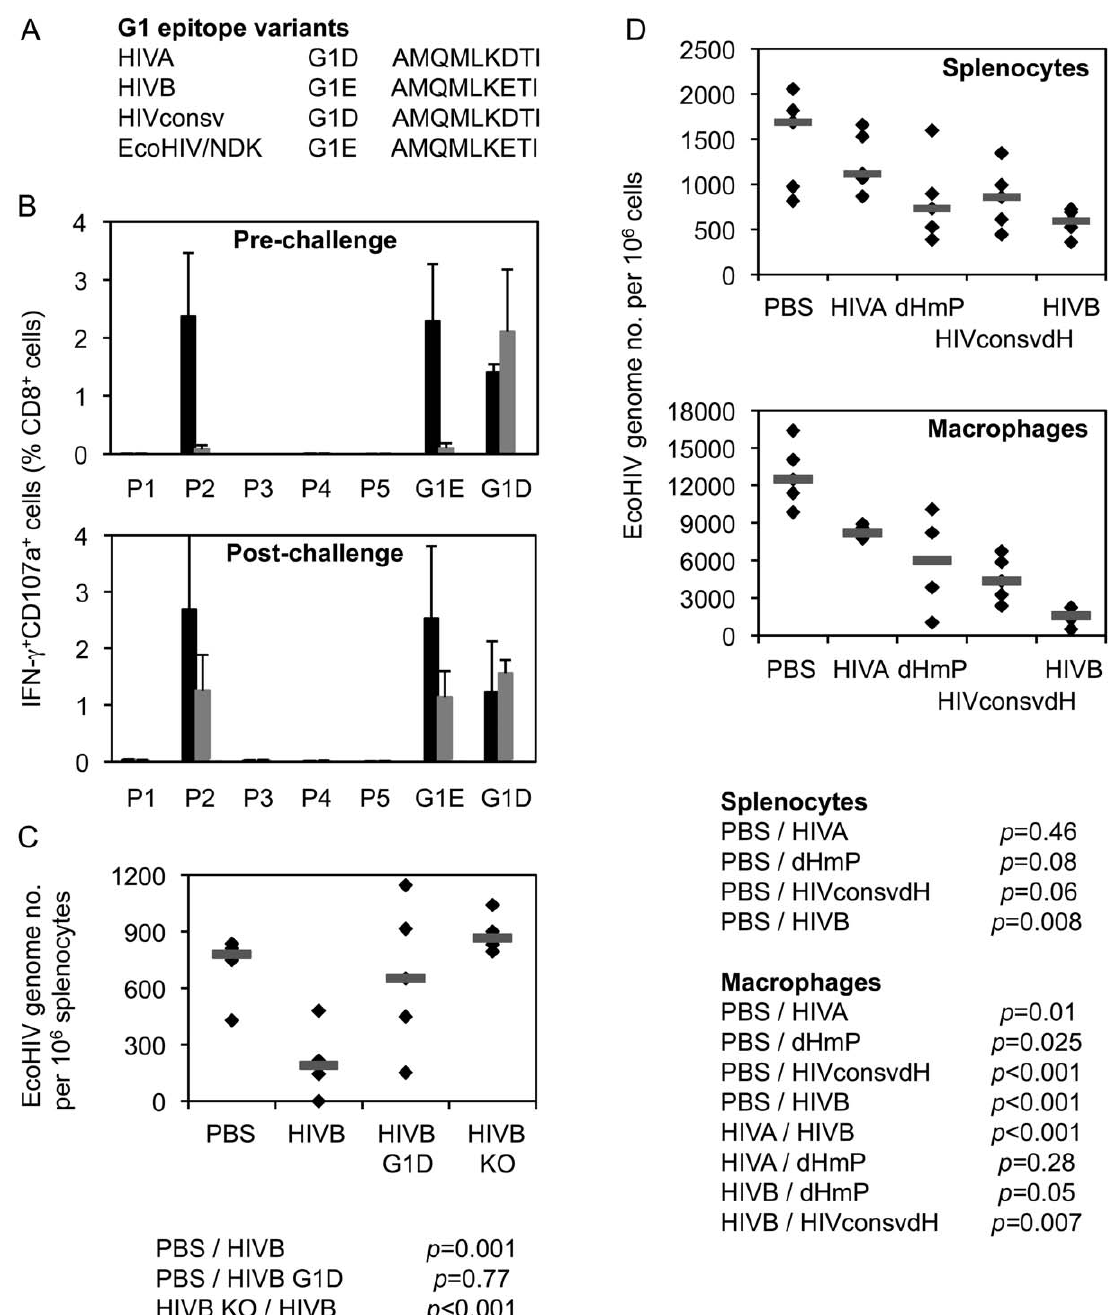
Figure 7. G1 epitope-specific CD8 + T cell responses confer protection against EcoHIV/NDK challenge. A) G1 epitope variants in the three used immunogens and the challenge EcoHIV. B) Eight BALB/c mice received 2x 100 m g of DNA of the HIVB vaccine containing epitope G1E (black bars), its G1D variant (dark grey bars) or knock-out versions (KO; light grey bars) and their HIVB-induced responses were determined before (n=3) or after (n=5) challenge with EcoHIV/NDK delivered 5 d after the last vaccination. For ICS assay, 5 pools (P1–P5) of overlapping peptides 15/11 across the whole HIVB protein and peptides G1E or G1D were used for re-stimulation as indicated below the graphs. Results are shown as mean 6 SD. C) The 3 vaccinated and 1 unvaccinated control groups of 5 mice were challenged with EcoHIV/NDK and the EcoHIV/NDK loads in splenocytes were determined using qPCR. The horizontal bars indicate group mean of the genome copy number per 10 6 splenocytes. D) Mice were immunized as above with plasmid DNA expressing four different immunogens HIVA, dHmP, HIVconsvdH or HIVB containing variants of the G1 epitope or left naı¨ve as indicated below the graphs and challenged with EcoHIV/NDK 5 d later. The EcoHIV/NDK load was determined in the splenocytes and peritoneal macrophages using qPCR. Group means are indicated by horizontal bars.